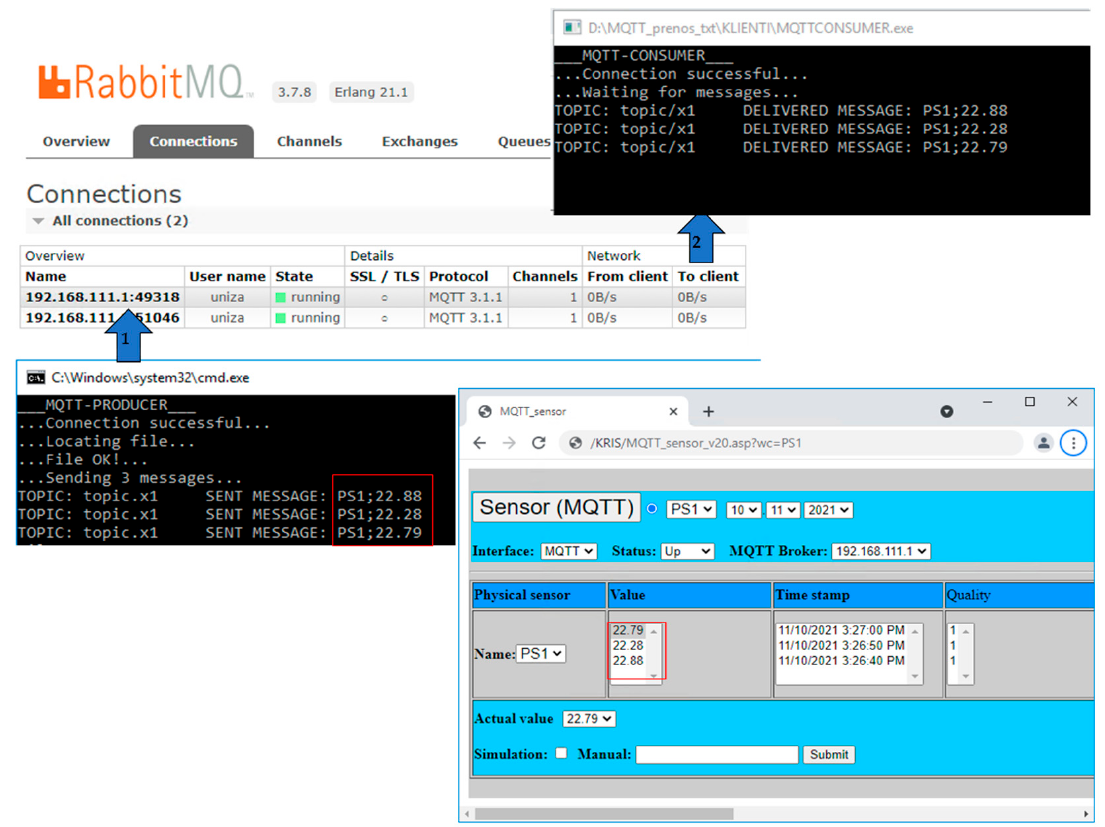
Figure 11. Emulated physical sensor with MQTT client.